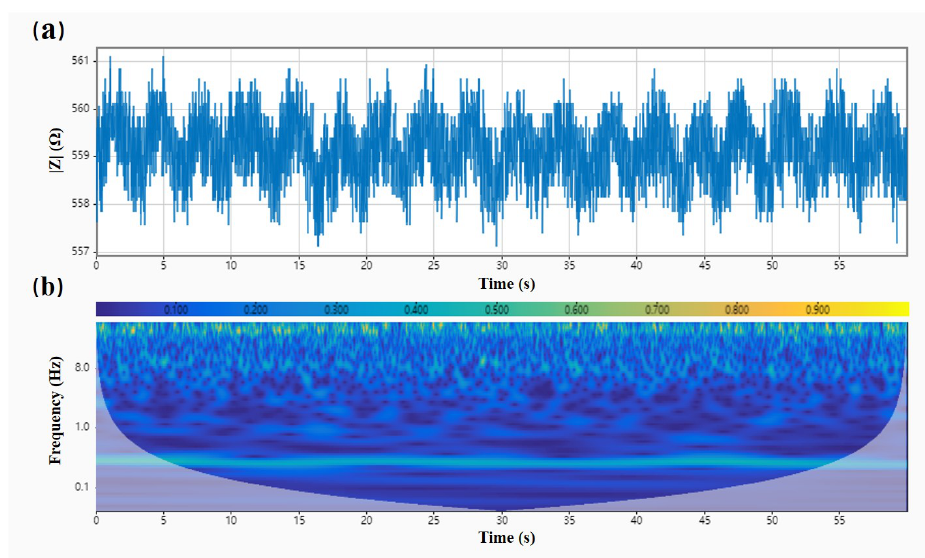
Figure 6. Impedance data of the head and their time–frequency distribution. ( a ) Subject one’s head impedance amplitude changes during breathing. ( b ) Head impedance time–frequency diagram during breathing in subject